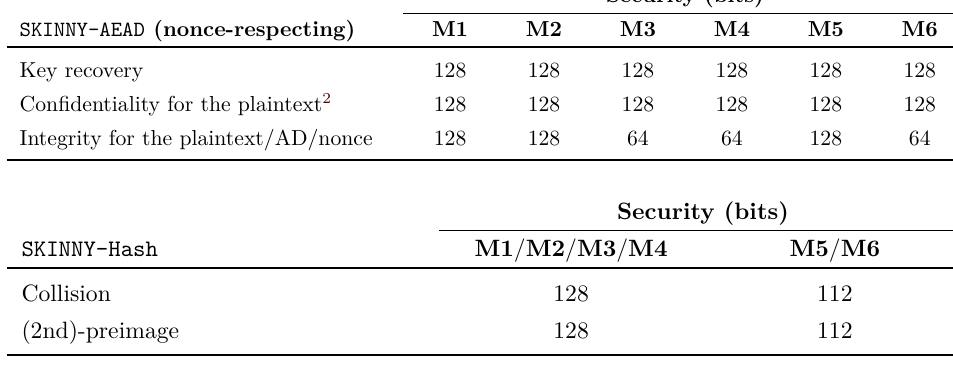
Table of Parameters and Security of SKINNY-Hash